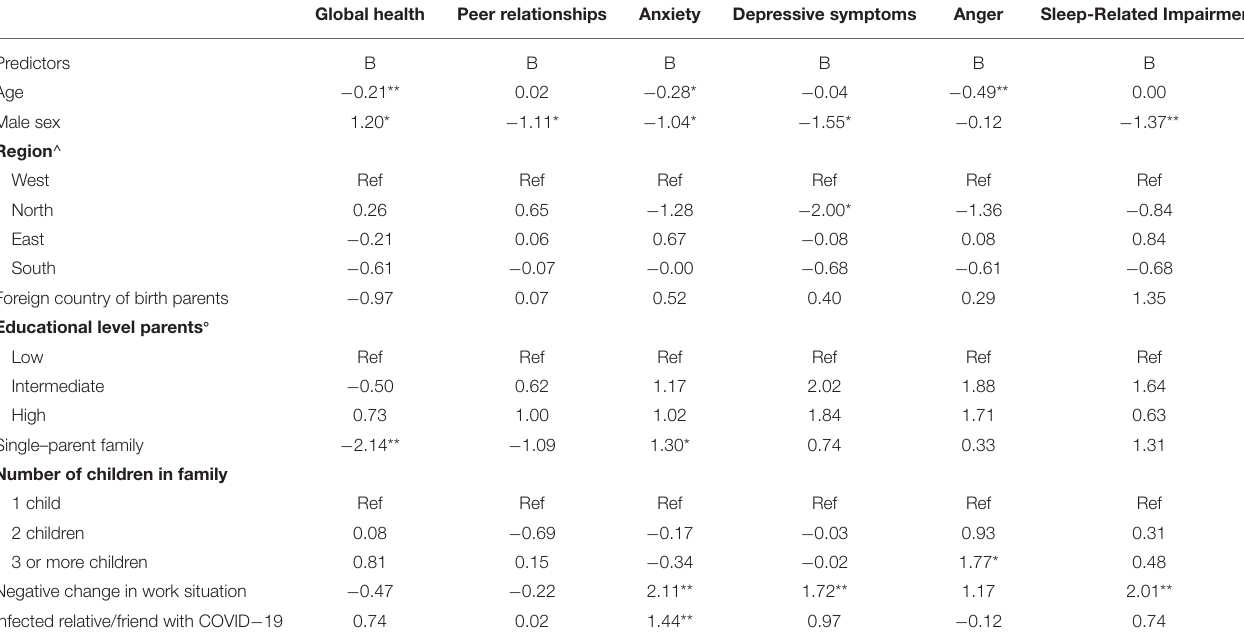
TABLE 3 | Unstandardized regression coefficients of independent variables of the ANCOVA for mental and social health outcomes. Global health Peer relationships Anxiety Depressive symptoms Anger Sleep-Related